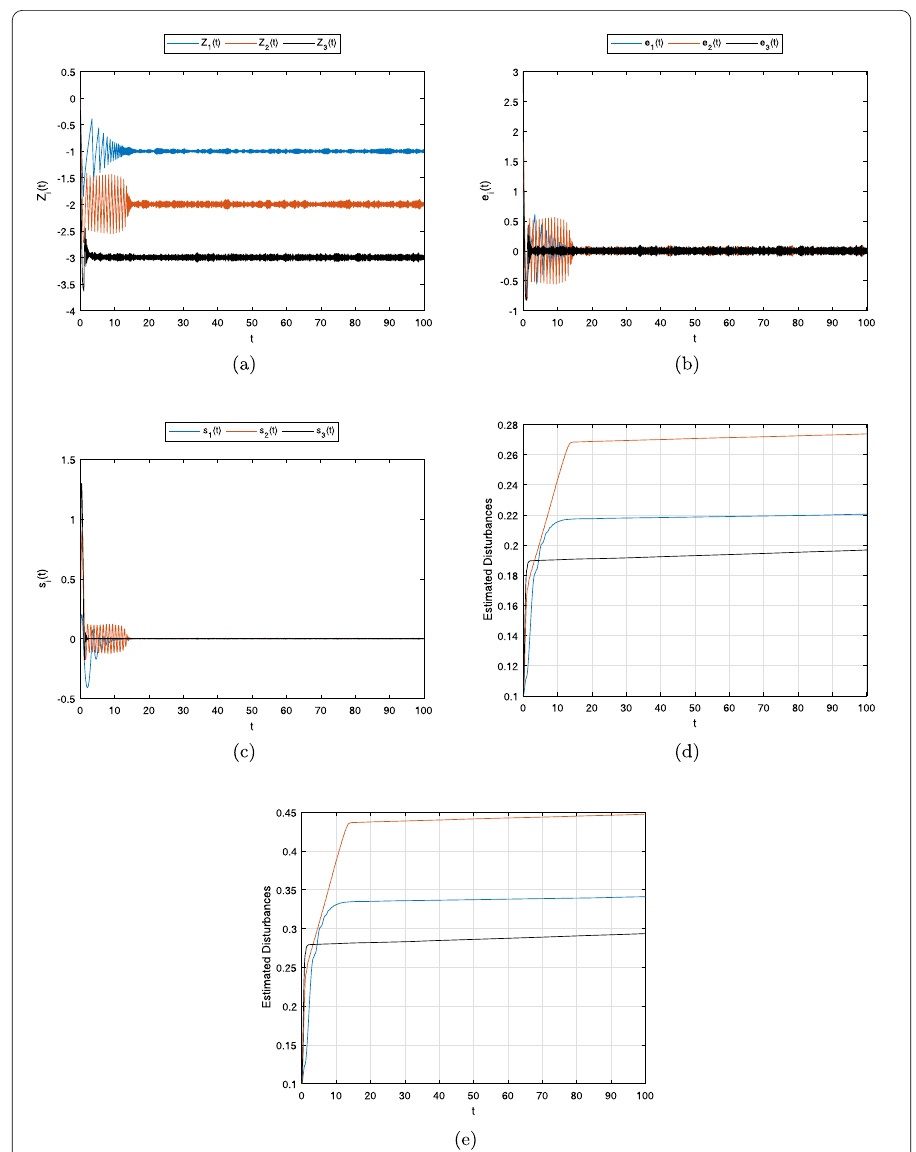
Figure 9 Controlling chaos about (–1,–2,–3) ( b ) with error, surface and estimated disturbances